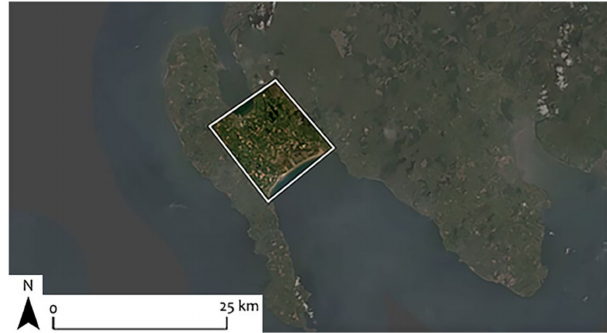
Figure 3. Stranraer area of interest [26]. Centred on 54 ◦ 52 (cid:48) 27”N, 4 ◦ 58 (cid:48) 76”W; see Figure 2 for location. © Planet Labs Inc.